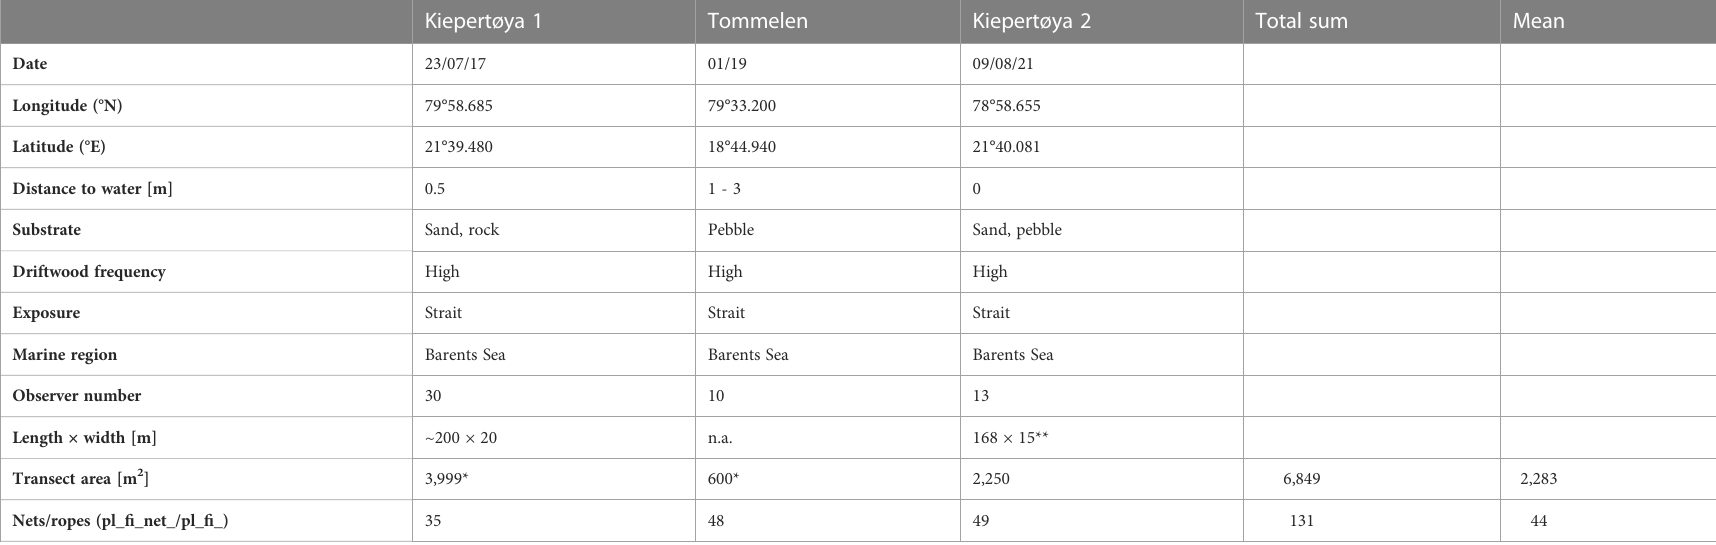
TABLE 3 Summary of results of high-resolution analyses of beach debris in big